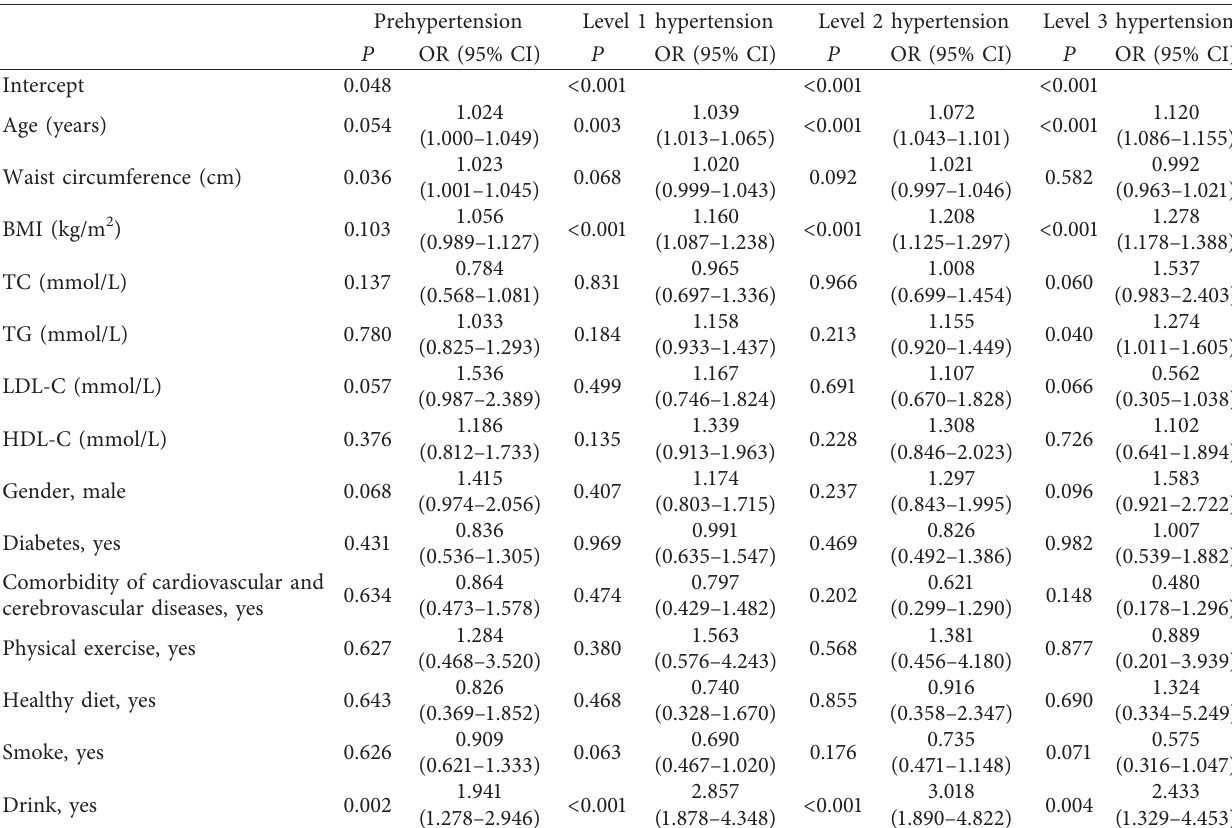
Table 3: Multinomial logistic results of variables with hypertension in the population without awareness